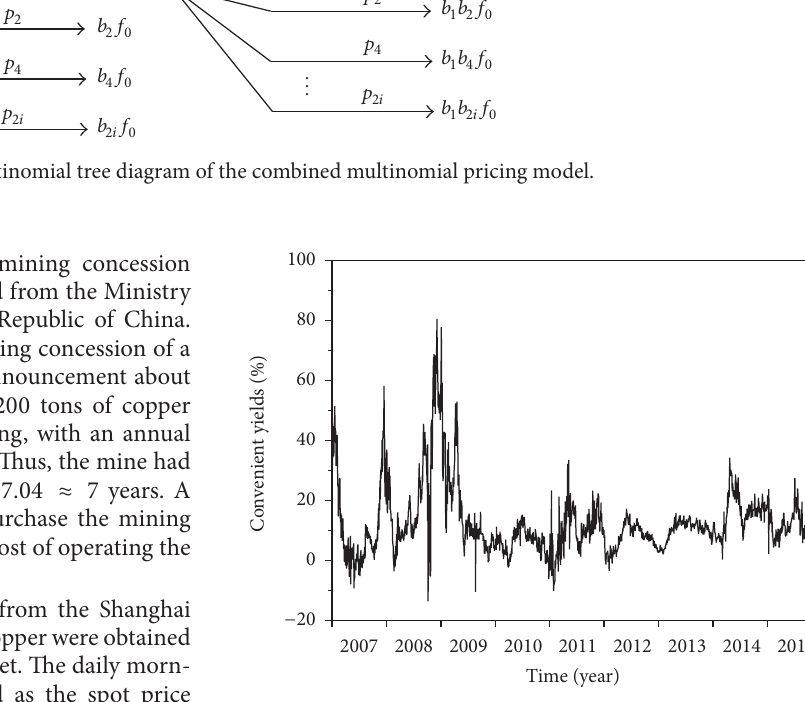
Figure 2: The daily convenience yield of copper between 2007 and